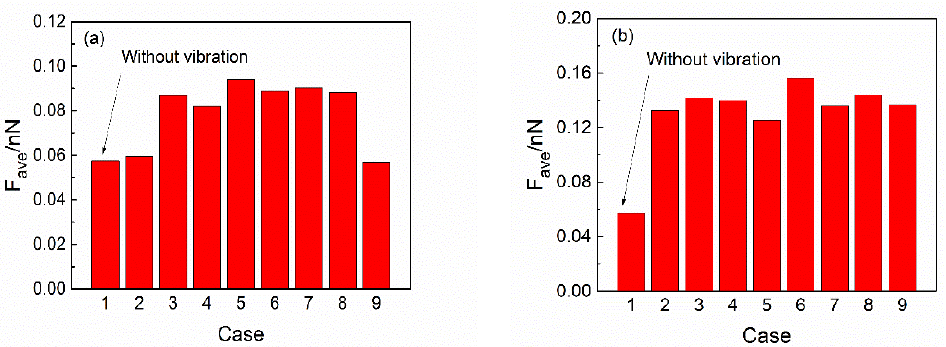
Figure 3. The average friction in a higher vibration frequency range. ( a ) Vibration amplitude of the virtual atom is 0.1 nm. ( b ) Vibration amplitude of the virtual atom is 0.5 nm. Vibration frequencies in 2–9 cases are 3.333 × 10 4 , 3.330 × 10 3 , 330, 319, 285, 250, 100, and 10 GHz, respectively.